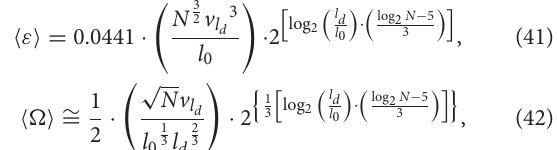
1; (C) ξ 1.5; and (D) ξ = =